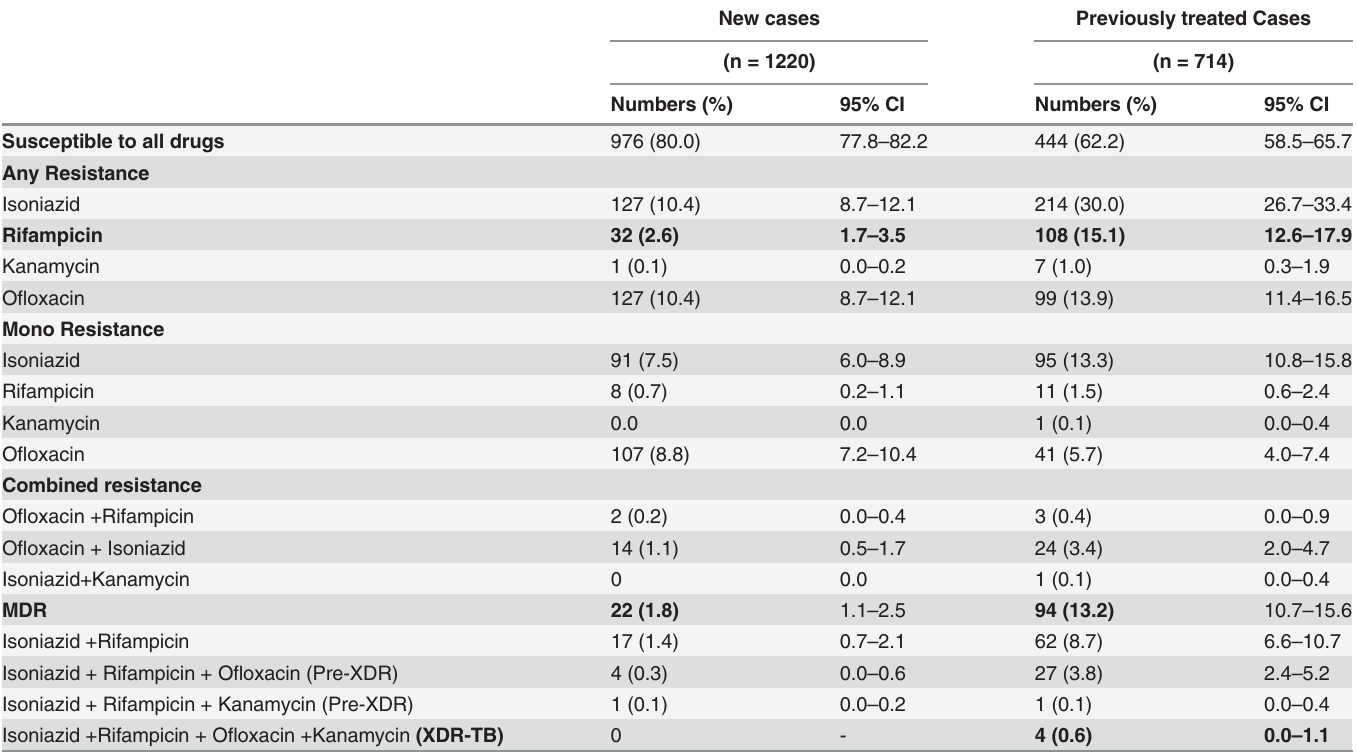
Table 2. The prevalence of resistance to fi rst and second line anti-TB drugs among M . tuberculosis isolates from new and previously treated cases of